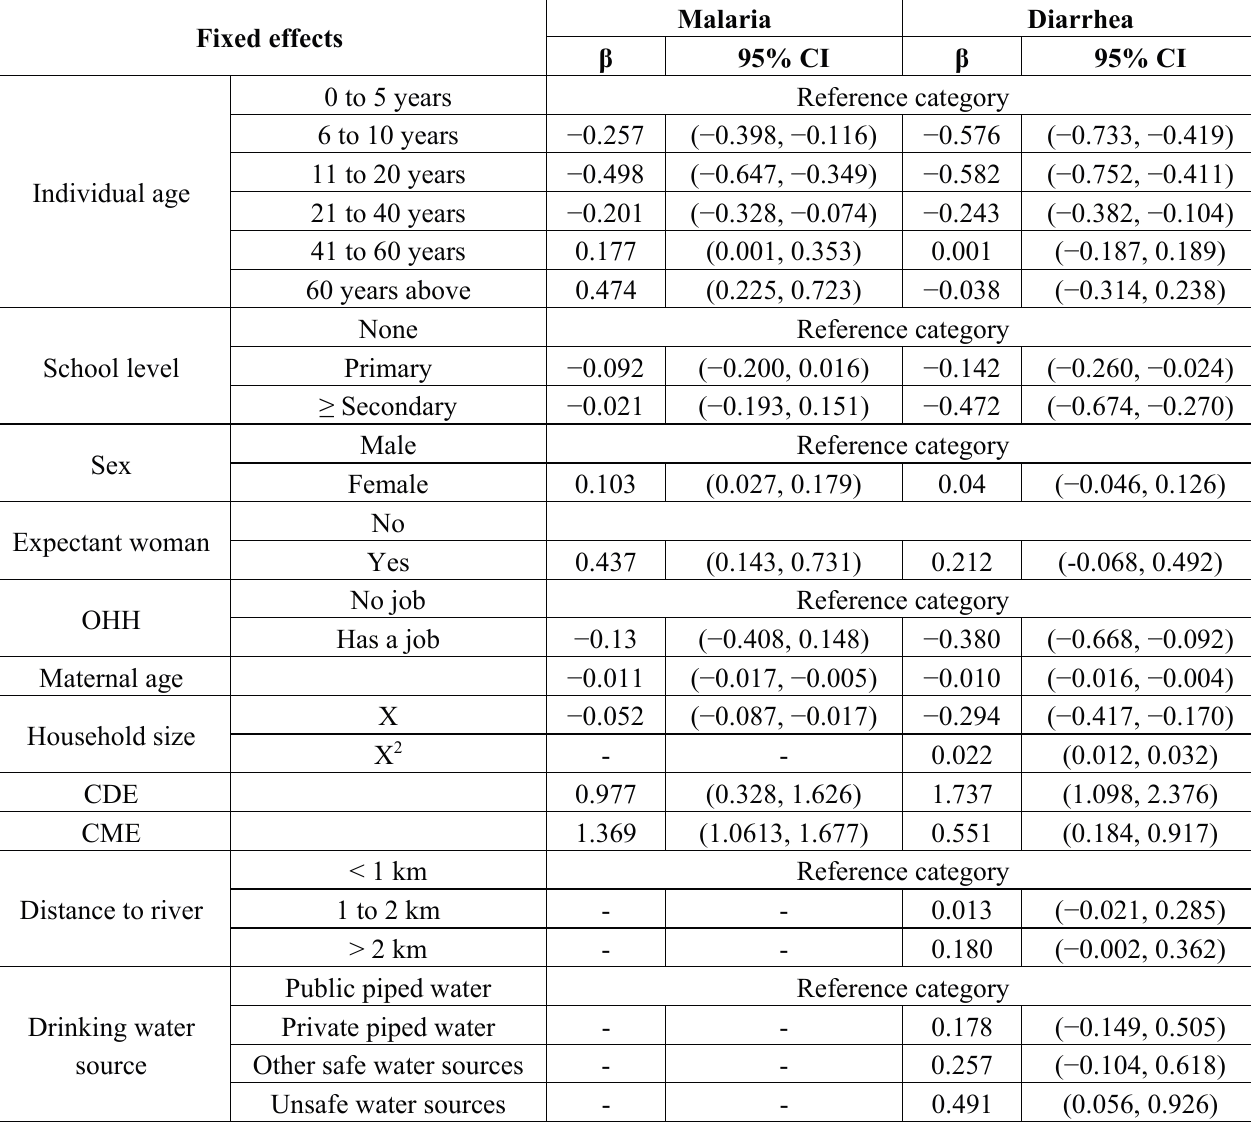
Table 2. Fixed effects estimates from the bivariate model of malaria and diarrhea coexistence in Chikhwawa